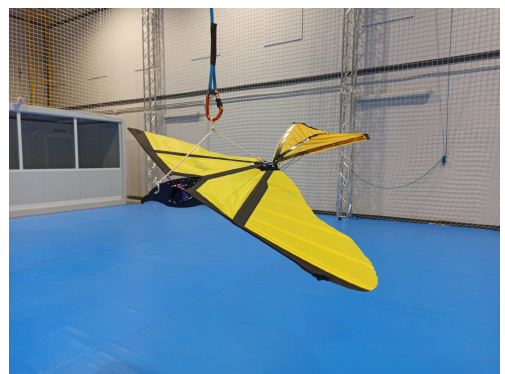
Figure 4. Final Prototype